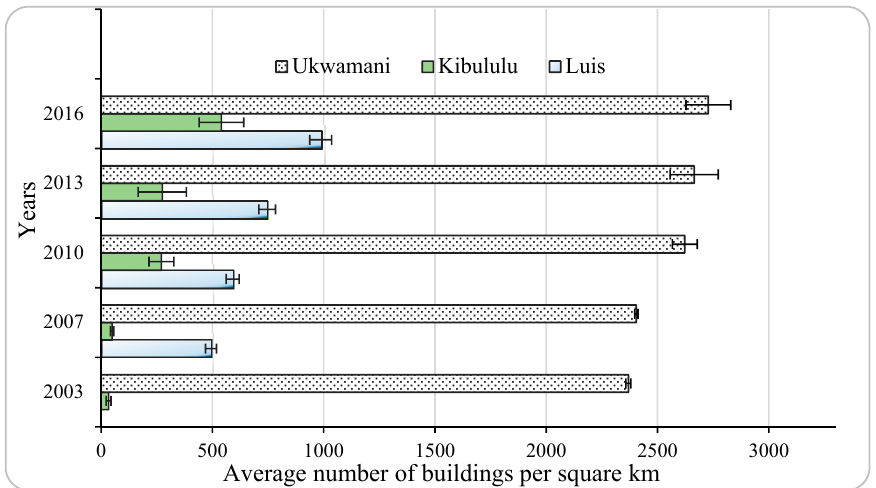
Figure 3. Bar graph comparing number of buildings per km 2 in sub-case areas for the past 13 years. The whiskers indicate the standard deviation of three individual samples from the mean value. No image was available for Luis 2003.